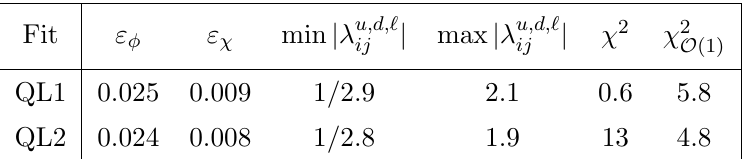
smallest and largest j (cid:21) u;d;e